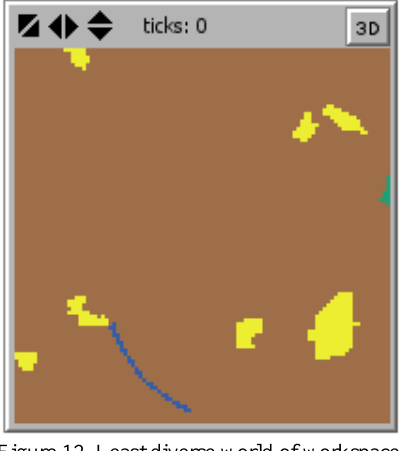
Figure 12. Least diverse world of workspace.